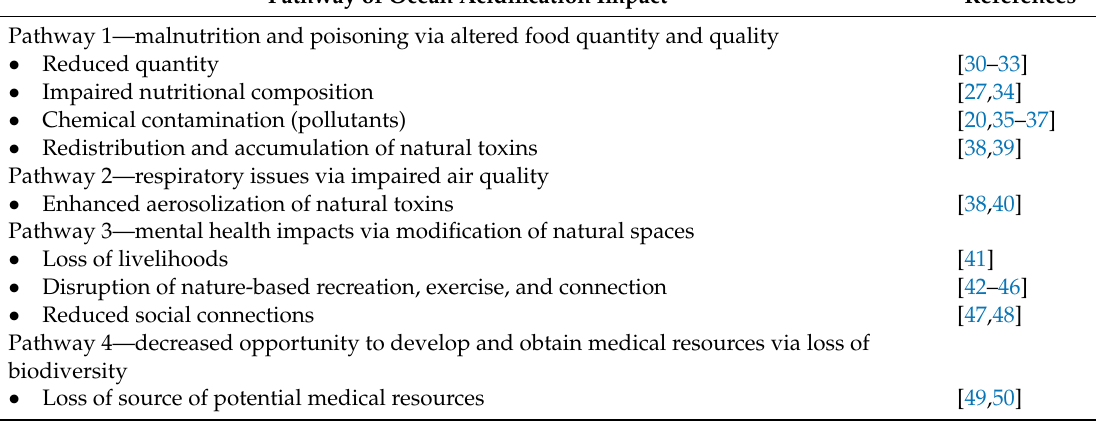
Table 1. Ocean acidification is predicted to negatively a ff ect four of the main services provided by the ocean (seafood, air quality, natural spaces, and marine biodiversity). Here, we highlight key changes included in each pathway and relevant